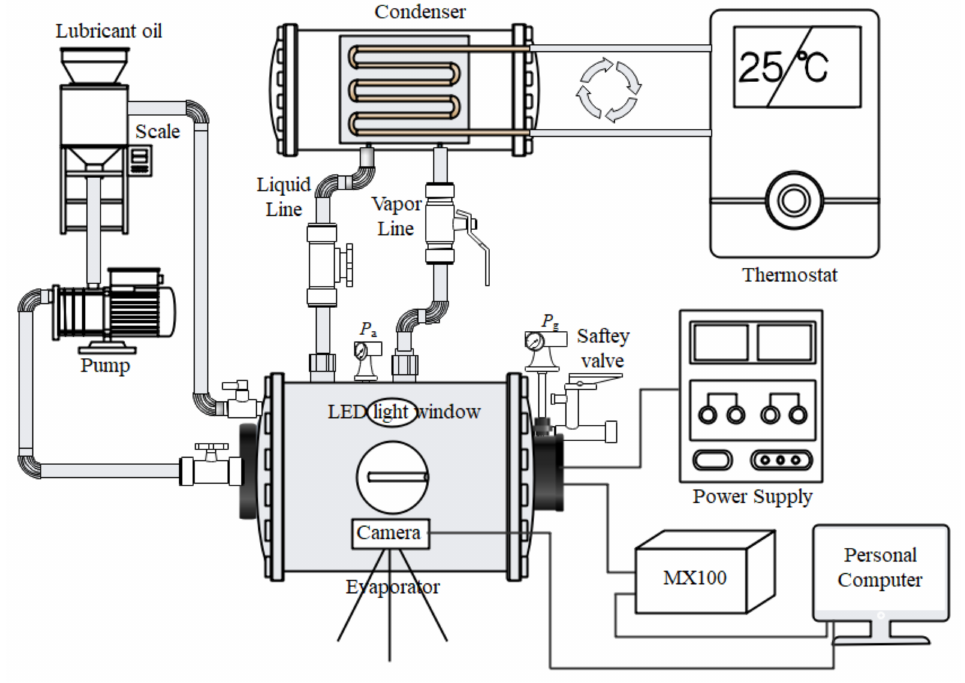
Figure 1. Schematic diagram of the experimental